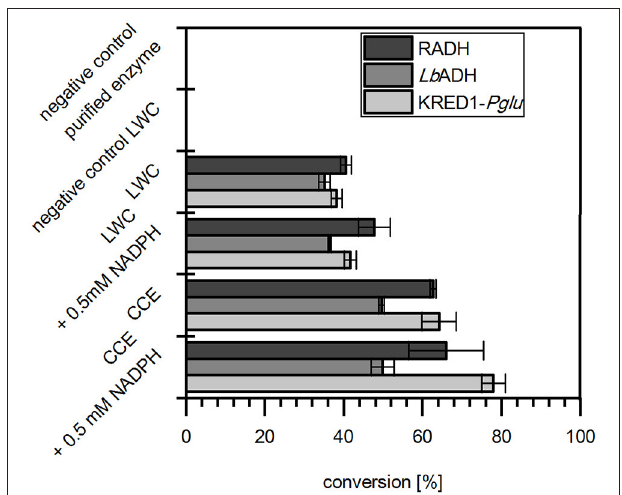
FIGURE 2 | Citrate operates as redox-equivalent regenerating agent in product synthesis. The capability of citrate to regenerate NADPH in a targeted oxidoreductase reaction was investigated with Ogataea glucozyma CBS 5766 ketoreductase1 (KRED1 -Pglu ), Lactobacillus brevis alcohol dehydrogenase ( Lb ADH), and Ralstonia sp. alcohol dehydrogenase (RADH) as lyophilized whole cell (LWC) and crude cell extract (CCE) catalysts. Therefore, citrate was provided to regenerate through endogenous tricarboxylic acid cycle enzyme NADPH, which is consumed by the targeted oxidoreductases in the reduction of acetophenone. Only the “negative control purified enzyme” contained the oxidoreductases in purified form instead of LWC/CCE. The “negative control LWC”: contained all compounds except citrate. The reaction setups with “0.5mM NADPH” contained NADPH instead of citrate. n =